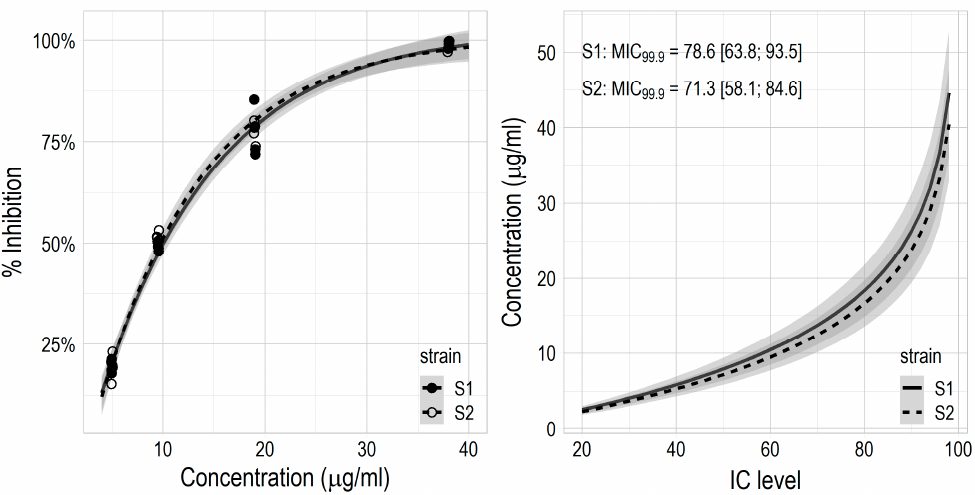
Figure 3. Inhibition of two Salmonella enterica strains (S1 and S2) using different concentrations of 1 (left) and IC50 levels and MICs (right).